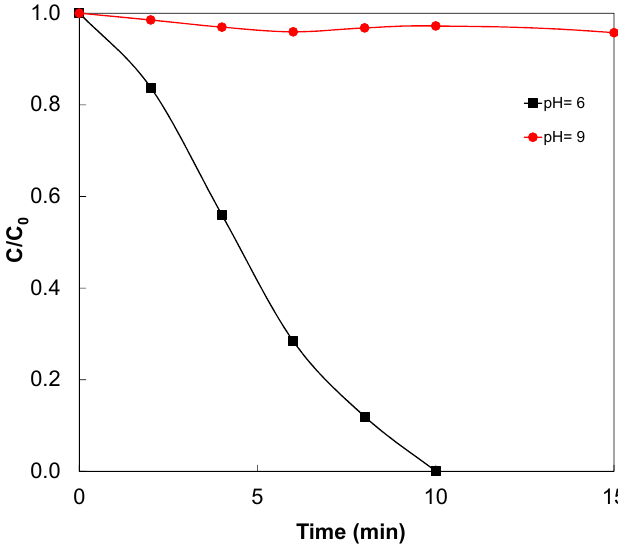
Figure 4. E ff ect of initial pH on SMX degradation in LNO / SPS system. Experimental conditions: Figure 4. Effect of initial pH on SMX degradation in LNO/SPS system. Experimental conditions: C SMX C SMX = 500 µ g / L; C LNO = 250 mg / L; C SPS = 100 mg / L; room = 500 μ g/L; C LNO = 250 mg/L; C SPS = 100 mg/L; room temperature.